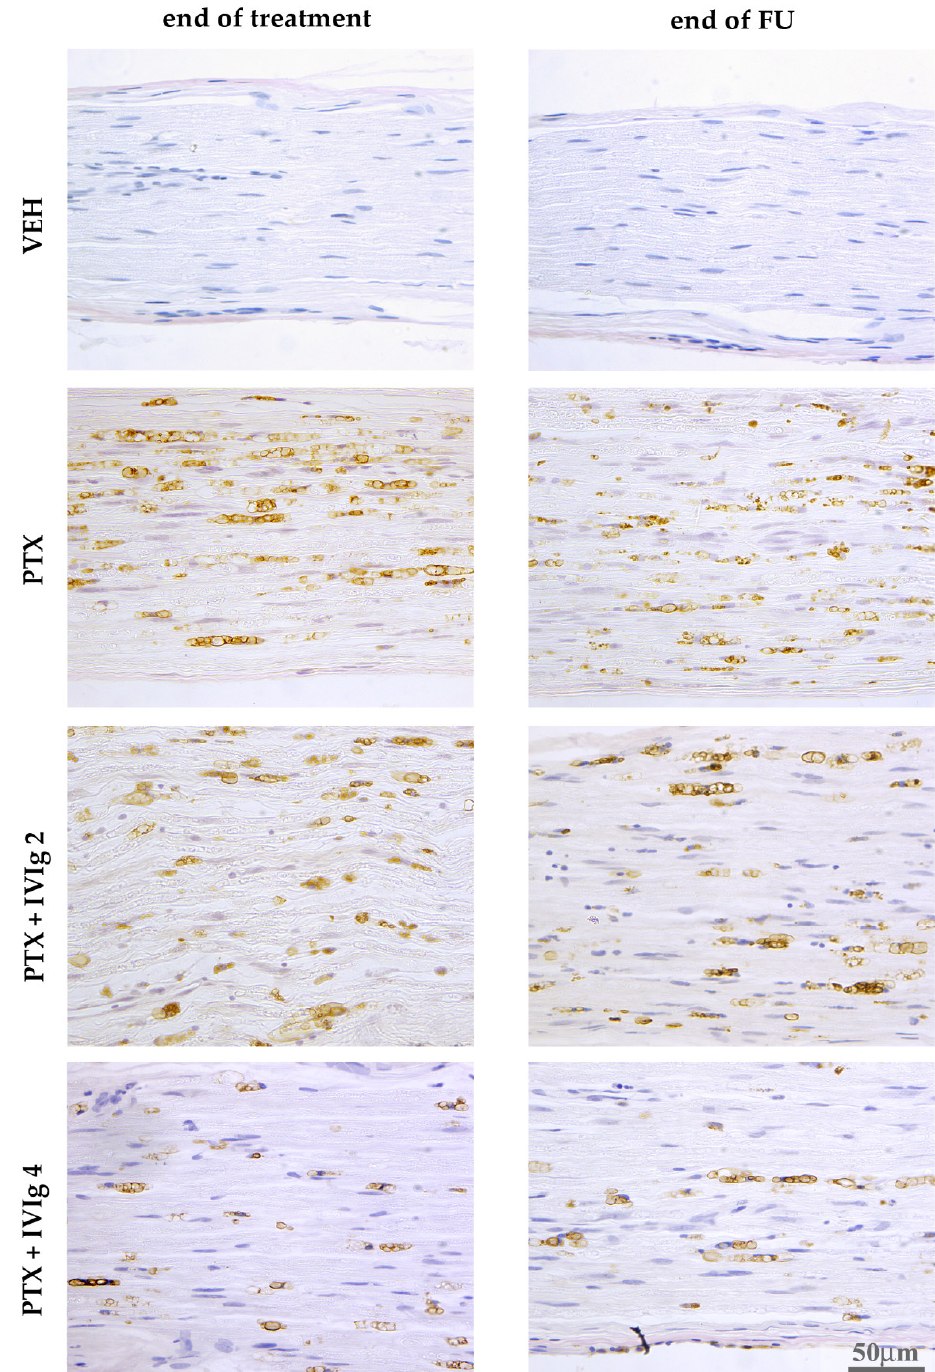
Figure 6. Immunolocalization of CD68 + macrophages in distal caudal nerves. IVIg + PTX co-treat- ment starting from the first day of PTX chemotherapy regimen induced a partial reduction in CD68 + infiltrating macrophages at both the end of treatment and after the follow-up period.